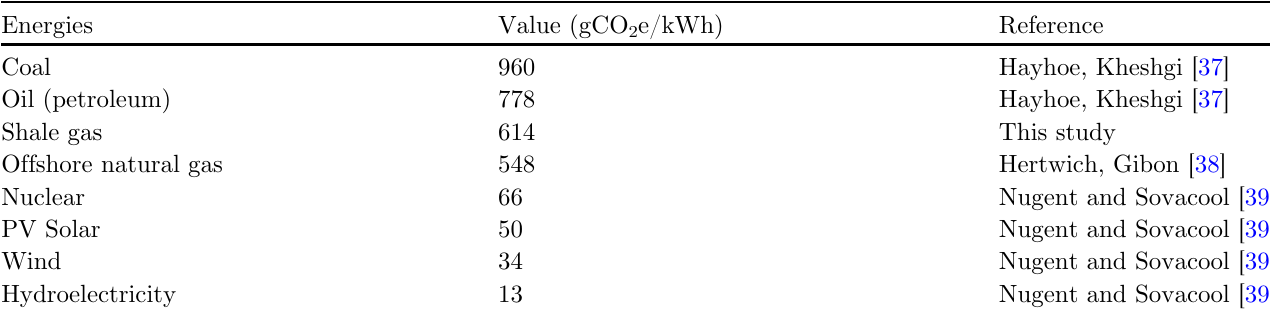
Table 4. Mean greenhouse gas emissions (gCO